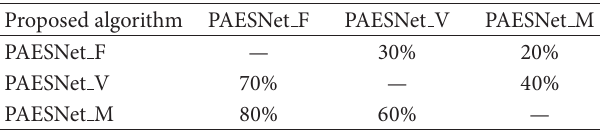
Table 5: Win rates for testing results across all 10 runs. Proposed algorithm PAESNet